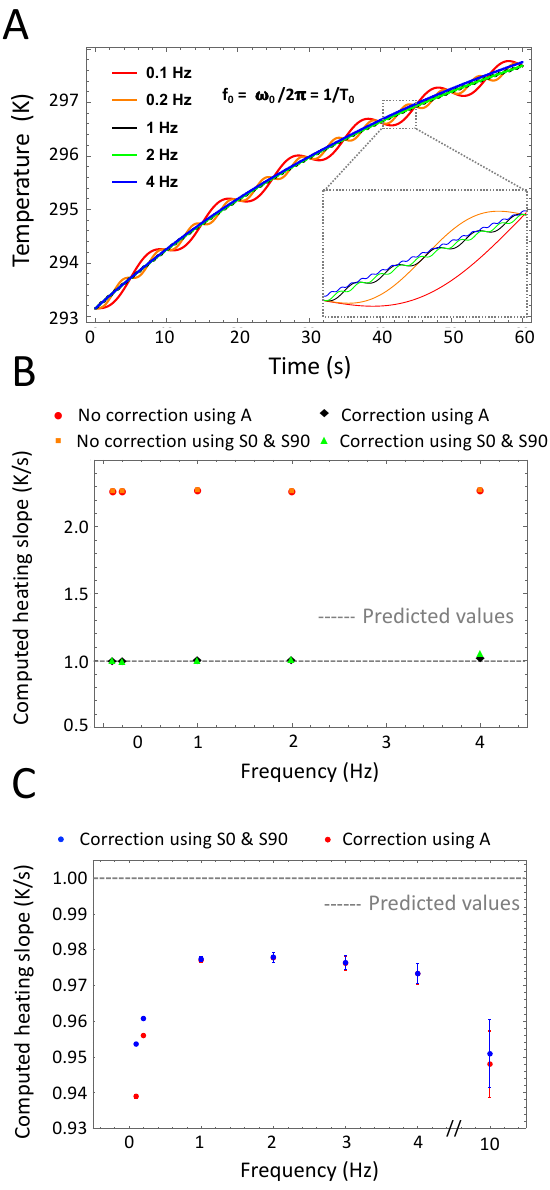
Figure 6. Variations of the stimulation frequency. ( A ): Time-dependent temperature of the sample for different stimulation frequencies. The stimulation frequency exhibits no effect on the duration of the thermal relaxation phase. ( B ): Computed heating slope β (normalized) for different stimulation frequencies. Correction for the unsteady initial heating is required for all frequencies. ( C ): Corrected heating slope values computed using the in-phase and in-quadrature signals or the amplitude alone. At low frequencies (less than 1 Hz), the exact calculation using the in-phase and in-quadrature signals leads to slightly more accurate